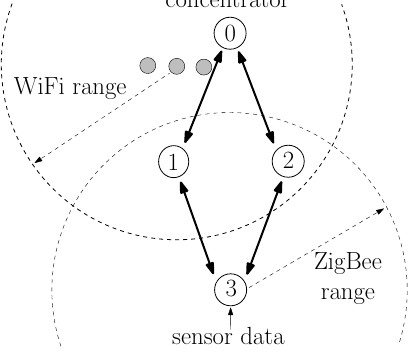
Figure 10. Topology where ZigBee devices share same spectrum as WiFi